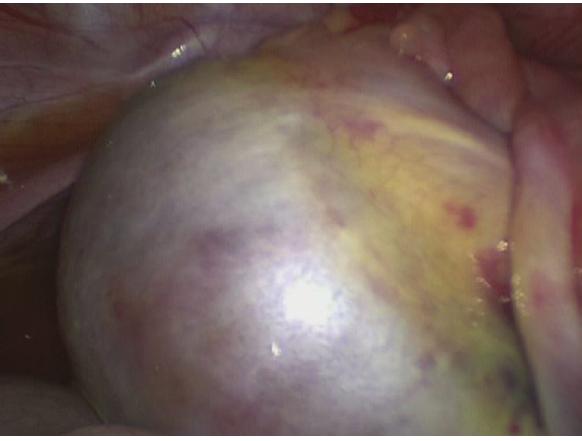
Fig. 2 Laparoscopic view of the right-sided mature ovarian teratoma.